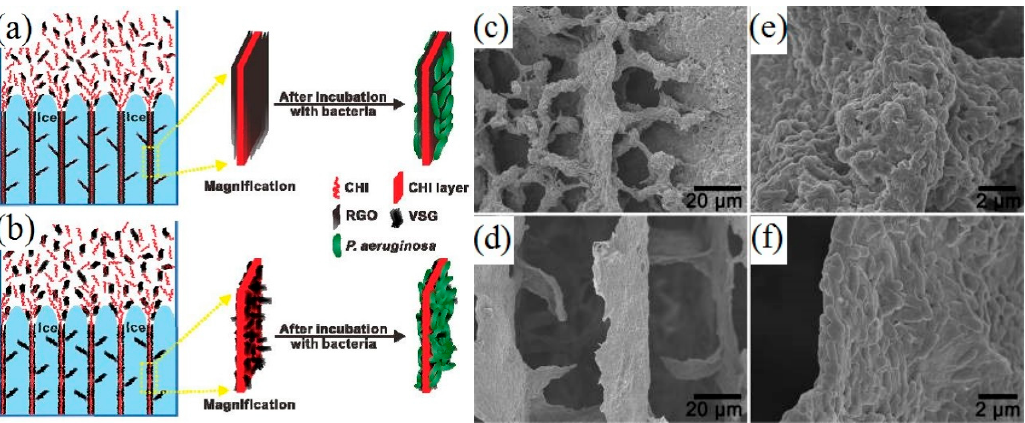
Figure 2. Schematic illustration of the layered and branched structure formation process of chitosan/reduced graphene oxide (CHI/rGO) ( a ) and chitosan/vacuum-stripped graphene (CHI/VSG) ( b ) scaffolds; SEM images of CHI/VSG ( c , e ) and CHI/rGO ( d , f ) scaffolds after incubation with bacteria at a low ( c , d ) and high ( e , f ) magnification. Adapted from [68], with permission from © 2012 American Chemical Society.